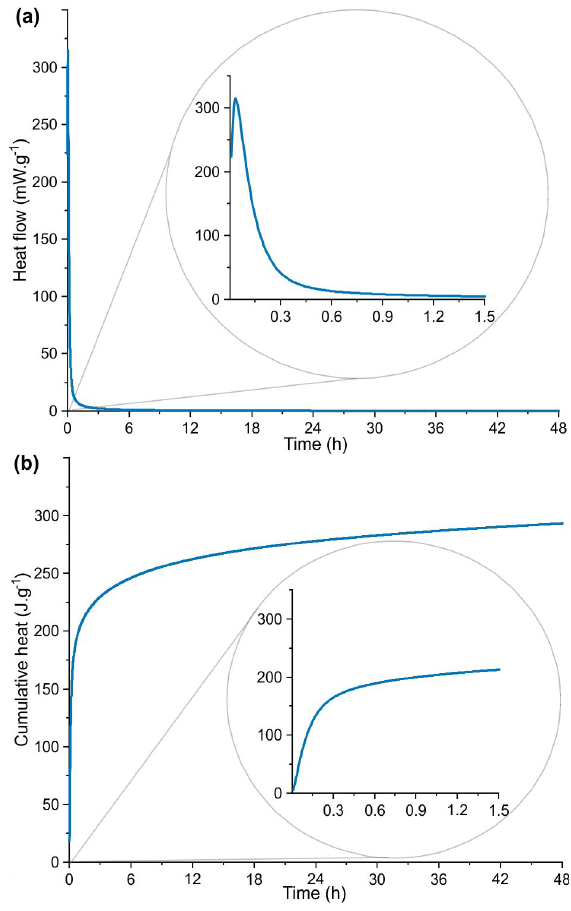
Figure 3. Heat flow (a) and cumulative heat (b) during 48-h of rehydration. These results agreed with those from previous